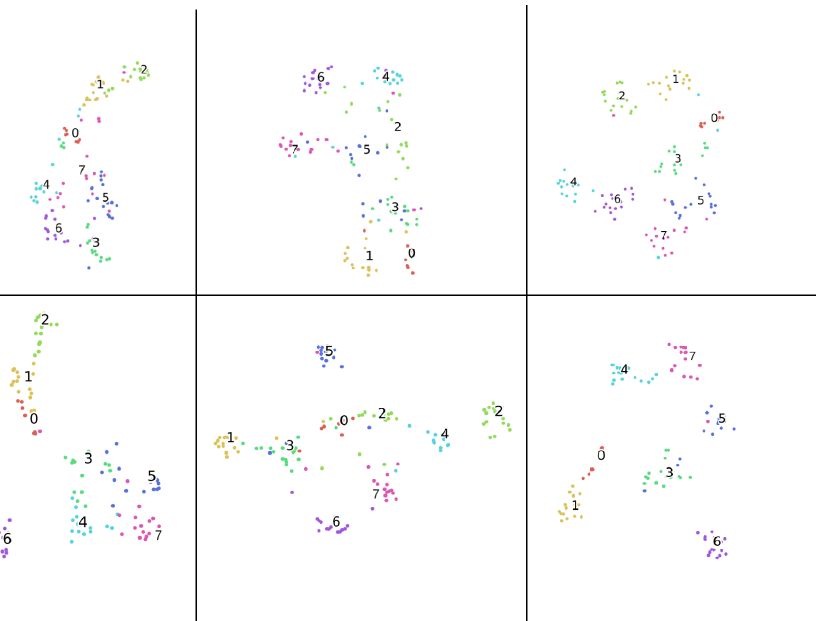
Figure 4. Visualization (t-SNE algorithm) of deep features clustering from two different setups where the train/validation sets are shuffled. The clustering with respect to emotion classes are listed. 0: Neutral; 1: Calm; 2: Happy; 3: Sad; 4: Angry; 5: Fearful; 6: Disgust; 7: Surprised. Top part : Clustering results from one setup of uni-modalities and multi-modality. Left part : Only image modality. Middle part : Only audio modality. Right part : Multi-modality. Down part : Clustering results from the other setup where train/validation sets are shuffled.